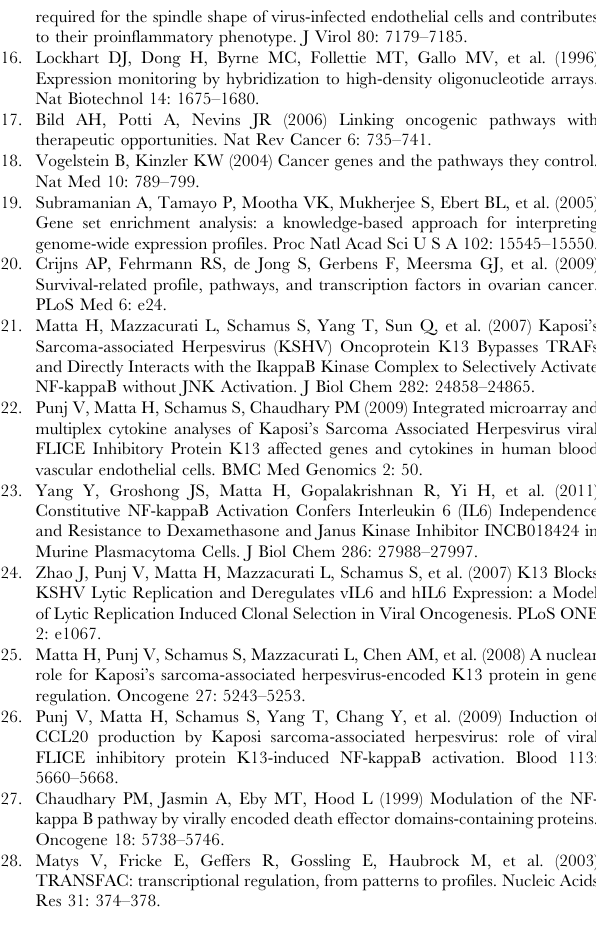
Table S2 Summary of differentially regulated gene clusters in 4OHT-treated K13-ER TAM -transduced BCBL1 cells. Table S3 List of common differentially regulated genes in HUVECs and BCBL1 cells. Table S4 List of genes upregulated . 20 fold in HUVECs dataset. Table S5 Summary of representative genes correspond- ing to pathways identified by GSEA analysis and validated in